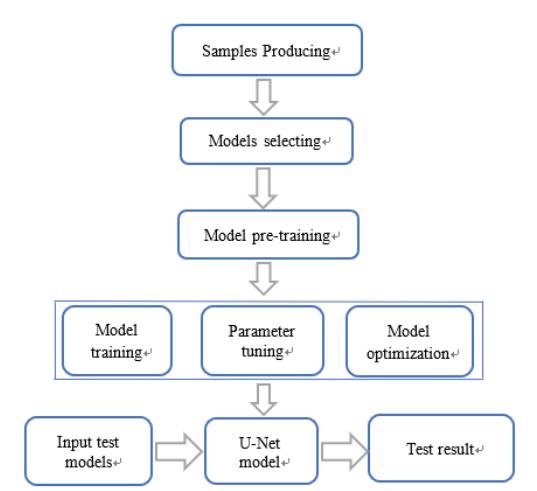
Figure 2. Design technical scheme flowchart